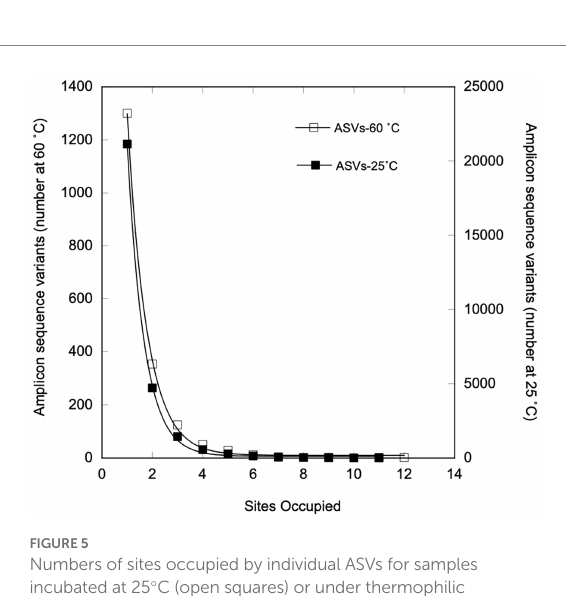
FIGURE 5 Numbers of sites occupied by individual ASVs for samples incubated at 25 ° C (open squares) or under thermophilic conditions (closed squares). The curve fit represents an exponential decay to a non-zero